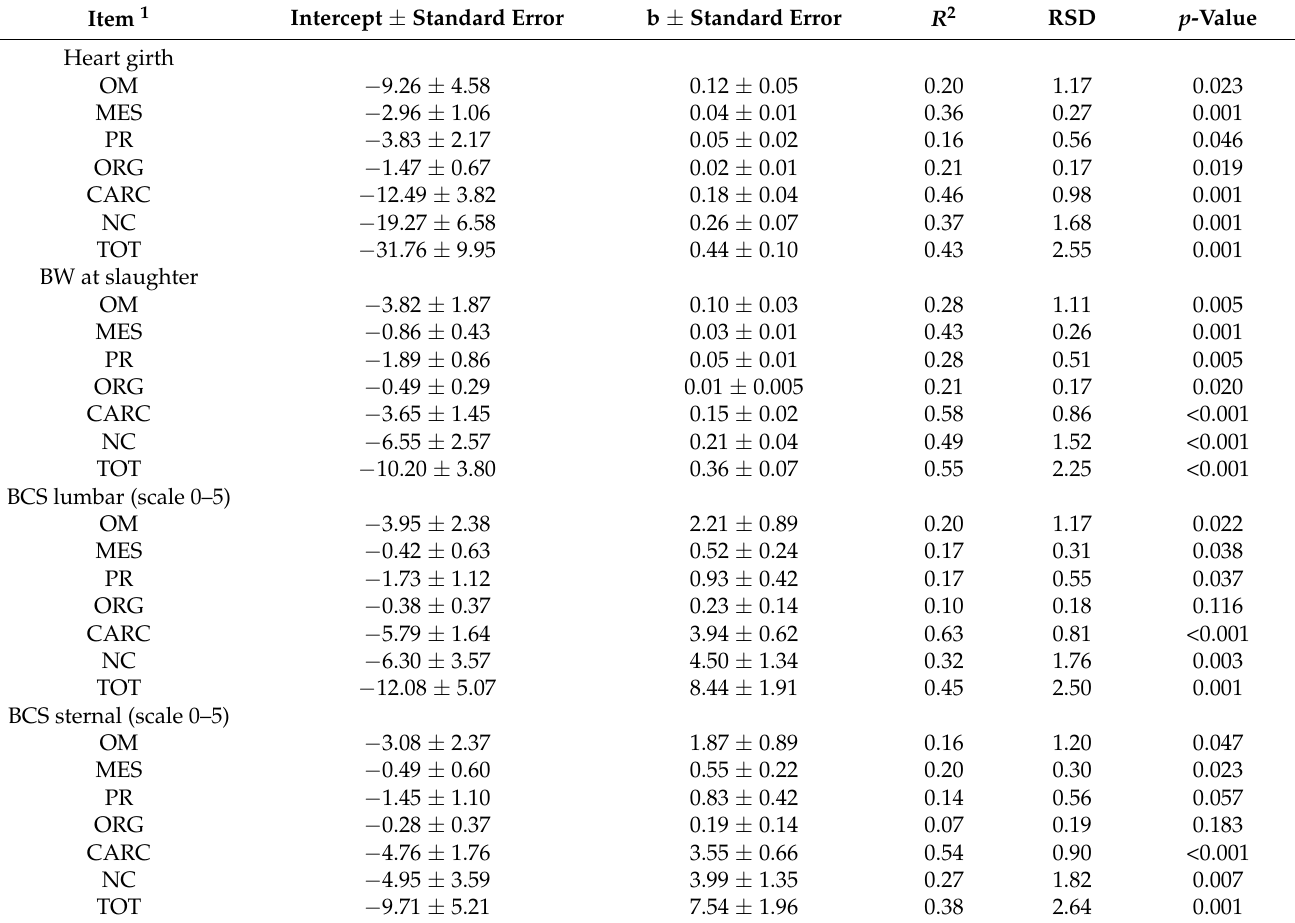
Table 2. Regression equations (y = a + bx), coefficient of determination ( R 2 ), and residual standard deviation (RSD) values for estimate of the different fat depot weights (kg) and the total weight of all fat combined (y variables) based on the pre-slaughter measurement values of heart girth, body weight (BW), and lumbar and sternal body condition scores (x